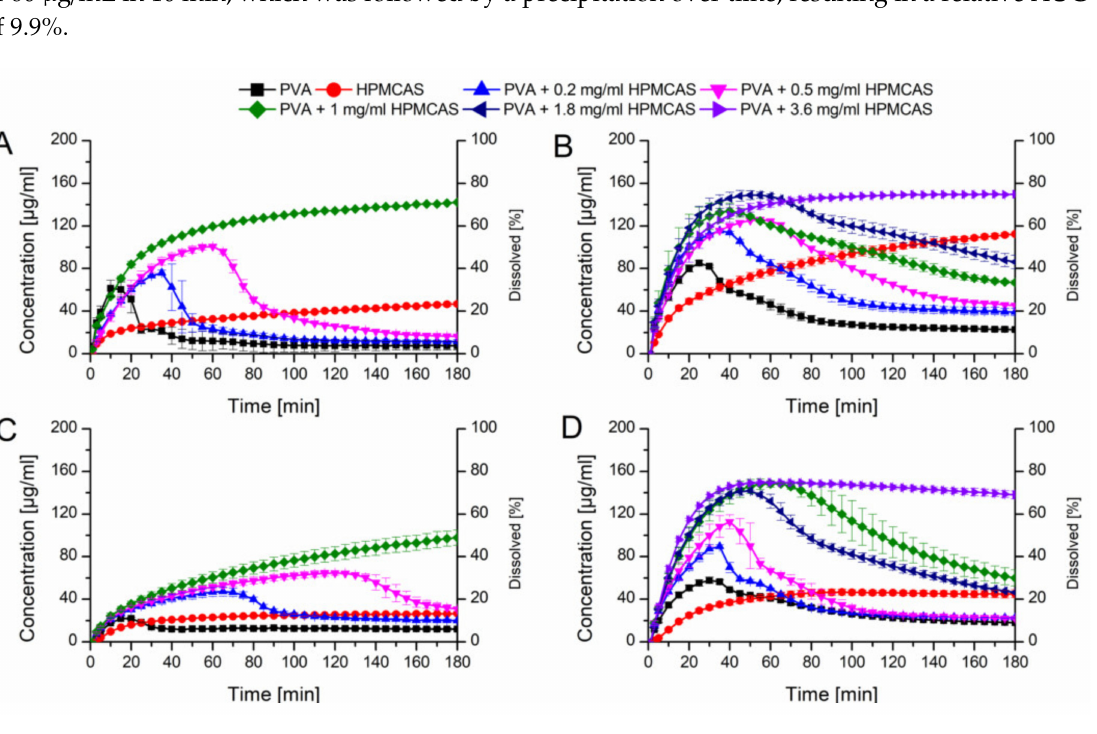
Figure 7. Monophasic non-sink dissolution studies of plain ASDs and of PVA ASDs in presence of predissolved HPMCAS at a drug load of 10% in PBS at pH 6.8 ( A ), in FaSSIF at pH 6.8 ( B ), at a drug load of 20% in PBS at pH 6.8 ( C ) and in FaSSIF at pH 6.8 ( D